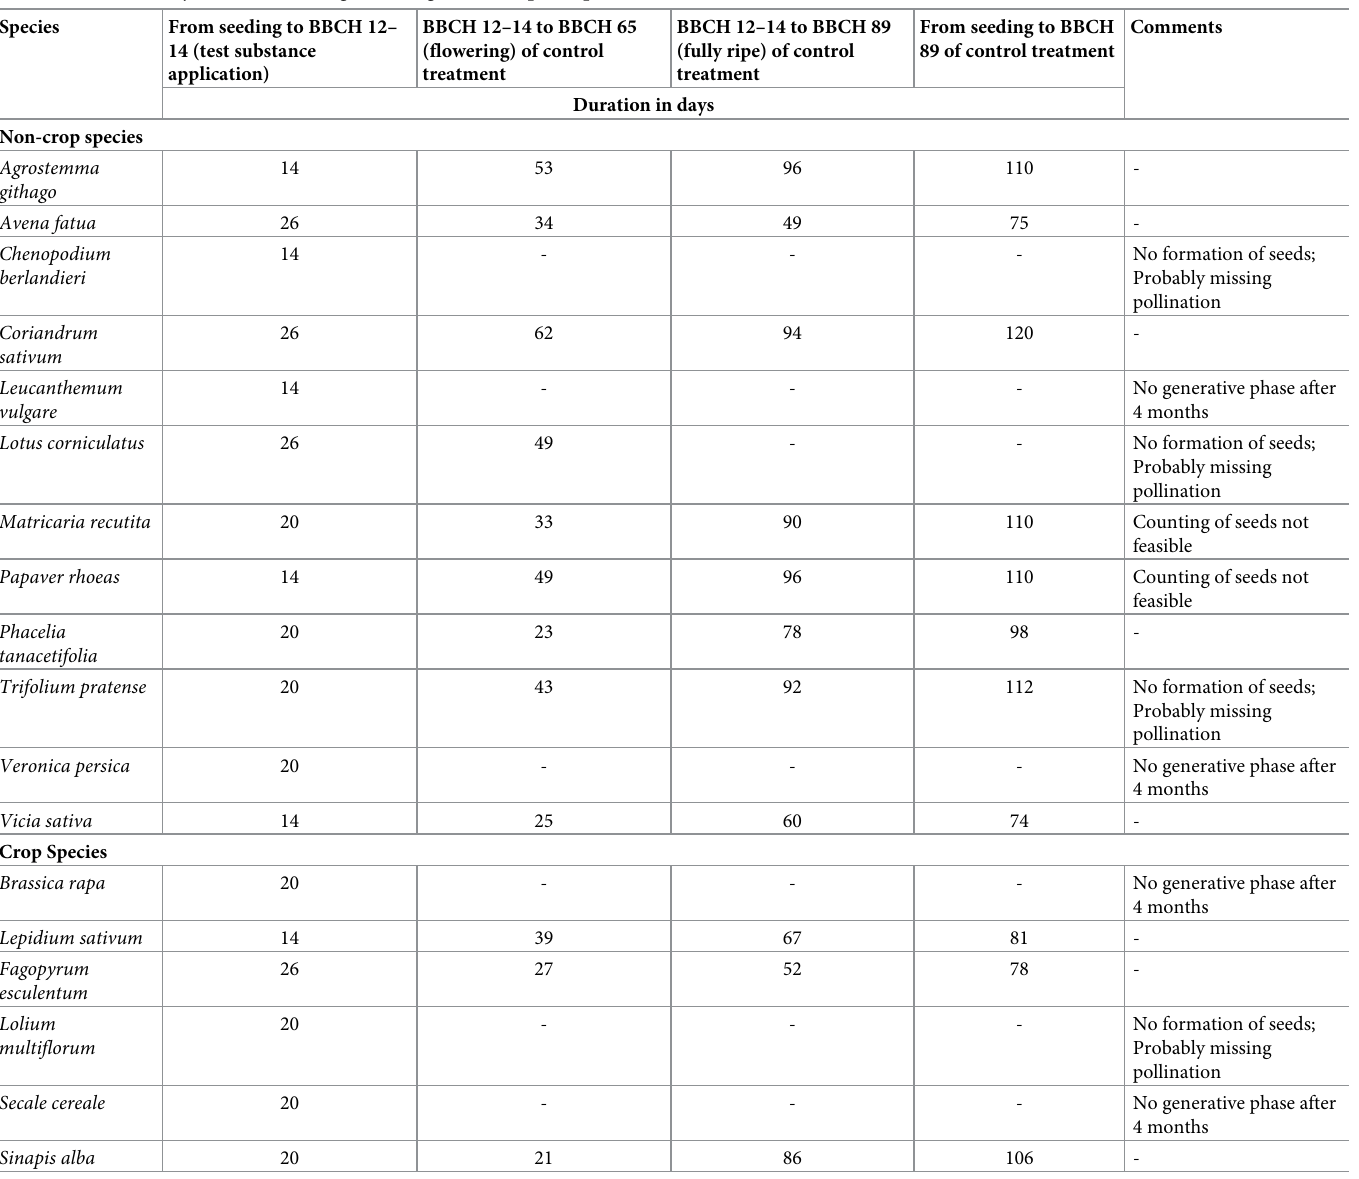
Table 3. Duration (days) of the different growth stages for each plant